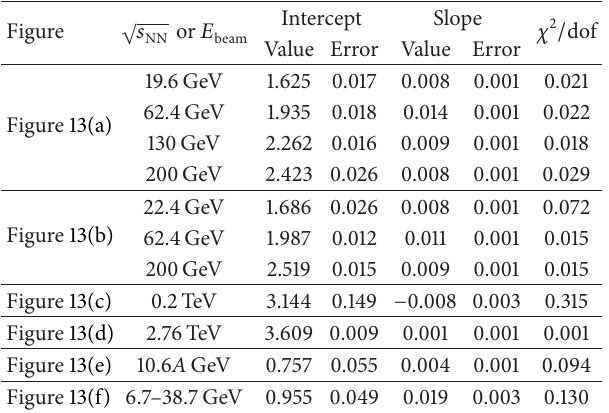
Table 8: Values of intercept, slope, and 𝜒 2 / dof for the linear relations 𝜎 - 𝐶 in Figures 13(a)–13(e) and for the linear relation 𝜎 - √𝑠 in Figure 13(f). NN